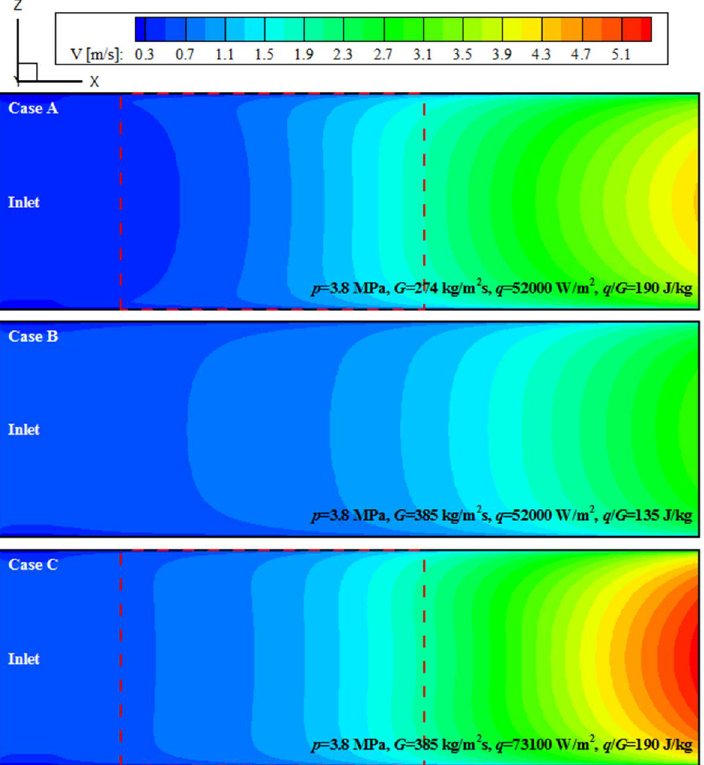
Figure 9. Comparison of velocity distributions in Section A-A (X:Z = 1:100) of the test tube at p = 3.8 MPa and T in = 101 K among the cases with different values of G or q . Four different cross-sections (i.e., axial locations X-1 to X-4 as shown in Figure 7a) were selected for comparative analysis to explain the variation of LHTC along the axial direction, taking the case with q / G = 190 J/kg as an example. The maximum LHTC occurred at X-2 while the minimum one occurred at X-4 in this case. Figures 10 and 11 present radial variations of temperature, thermophysical properties and flow parameters of N 2 within the region from z / r = 1 to 0.5 on the four selected cross-sections in this case. z / r = 1 and 0 denote the wall and the centerline of the tube, respectively. As marked in Figure 10a, the N 2 temperature gradually decreased to less than T pc along the radial direction away from the wall on X-1, X-2 and X-3, while it is above T pc within the whole region on X-4. The position of reaching T pc moved towards the centerline as the axial location moves from X-1 towards X-3. Combined with Figure 7a, it can be found that when T pc appears in the boundary layer adjacent to the wall, the LHTC began to increase and heat transfer enhancement was initiated. When T pc moved along the radial direction to a certain position within the boundary layer, LHTC reached its maximum. When T pc moved outside the boundary layer, significant heat transfer deterioration occurred. The specific heat ( c p ) varied sharply between 1 and 30 kJ/kg · K and reached the maximum at the position of reaching T pc on the three cross-sections, while it varied slightly between 1 and 4 kJ/kg · K on X-4, much smaller than that on other cross-sections as shown in Figure 10b. For convenience, the whole region was artificially divided into three subregions. Compared to other cross-sections, c p was larger on X-1 in Subregion I, on X-2 in Subregion II, but on X-3 in Subregion III. The thermal conductivity ( λ ), viscosity ( µ ) and density ( ρ ) all decreased nearly in the whole region except for some very small local zones when the cross-section moves from X-1 towards X-4 (see Figure 10c–e). The reduction of (cid:2025) and (cid:2034)(cid:1870)⁄ ) as Figure 10f (cid:2020) increases axial flow velocity ( (cid:1848) (cid:2034)(cid:1848) (cid:3051) ) and near-wall velocity gradients ( (cid:3051) shows. Although different buoyancy forces caused by different radial density gradients